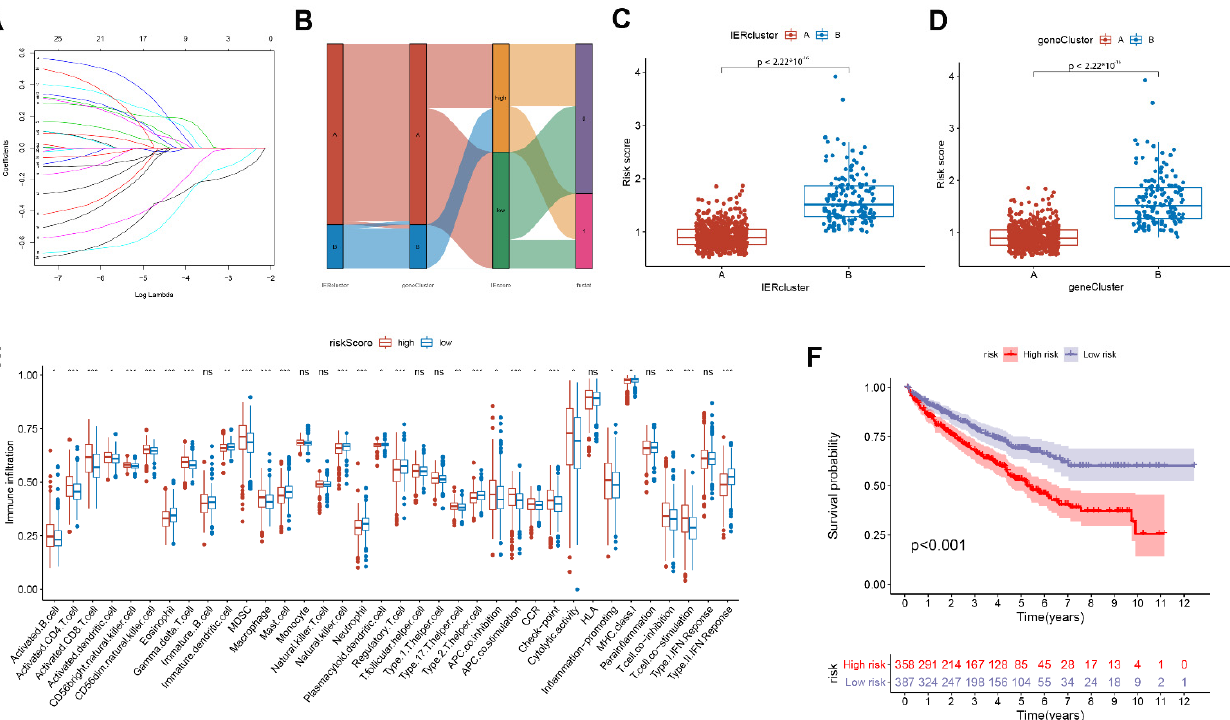
Figure 4. Calculate the immune escape score and explore potential clinical implications. ( A ) Calcula- tion of immune escape scores (IE scores) for ccRCC samples using lasso cox regression. ( B ) Sankey diagram of the relationship between IE scores and IER A and IER B clusters, geneCluster A and geneCluster B, and survival status of ccRCC samples. ( C ) Scatter plot of the relationship between IE scores and IER A or IER B clusters. ( D ) Scatter plot of the relationship between IE scores and geneCluster A or geneCluster B. ( E ) Differences in tumor immune microenvironment composition be- tween high IE score group and low IE score group. ( F ) Overall survival curves of high IE score group and low IE score groups using the Kaplan–Meier method. (*: p < 0.05; **: p < 0.01; ***: p < 0.001).